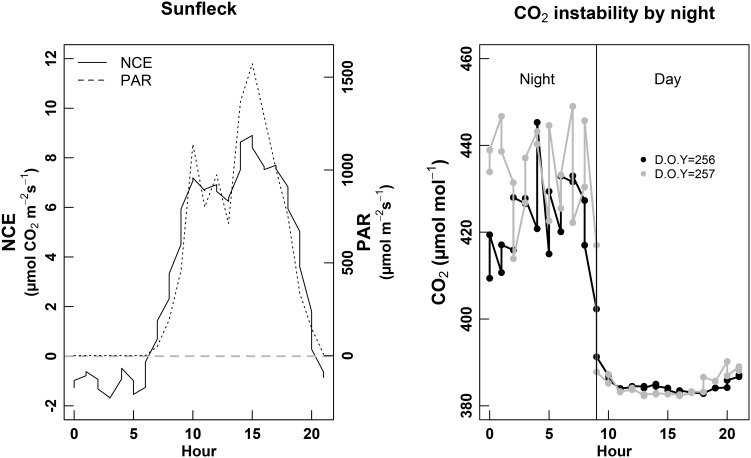
Left panel: example of sun fleck (PAR, discontinuous line) effect on the NCE (net carbon exchange of the whole-plant, continuous line). Right panel: monitoring of the [CO2] entering the chamber (atmospheric [CO2]) over a complete 24 h cycle, during two consecutive days (D.O.Y. 256 black line and D.O.Y. 257 gray line). The vertical continuous black line denotes the day/night limit.